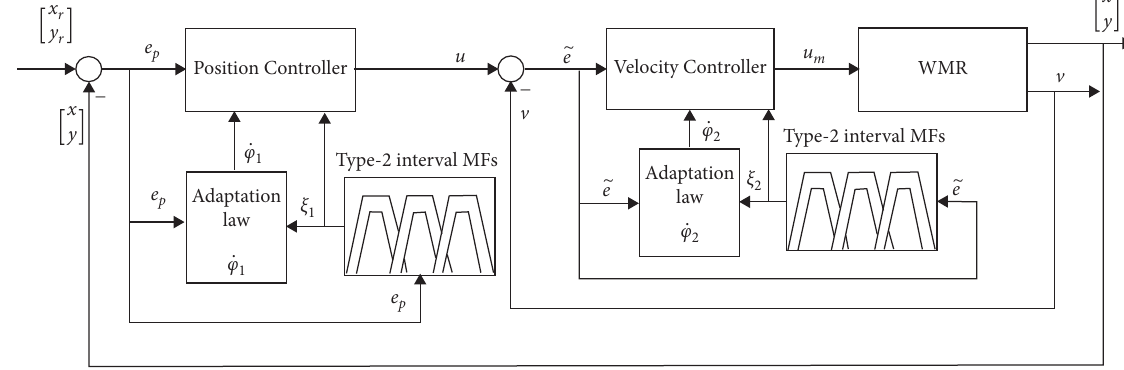
Figure 2: The control scheme for the wheeled mobile